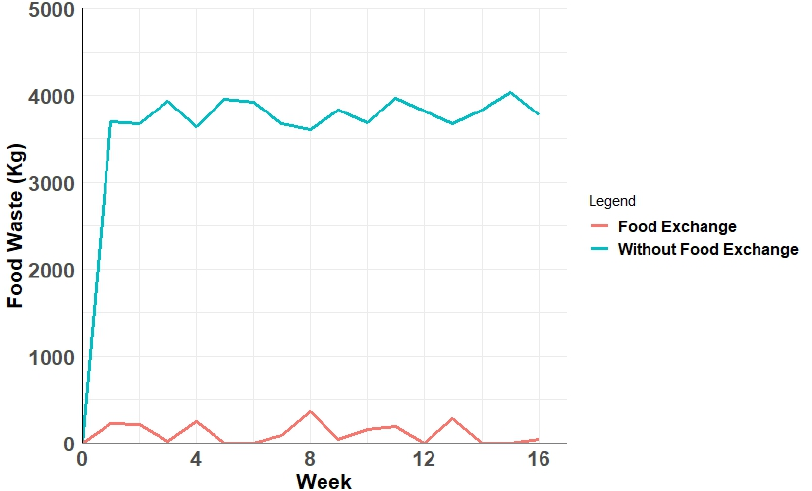
Figure 7. Food waste (kg) of all the farms over a 16-week period with and without Food Exchange